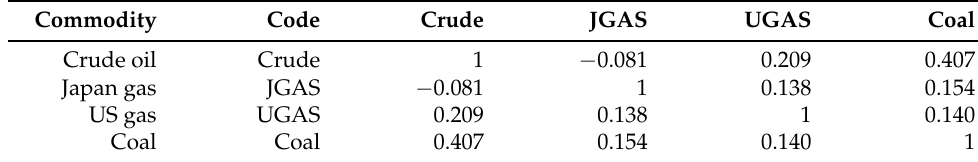
Table 3. Correlation table of energy